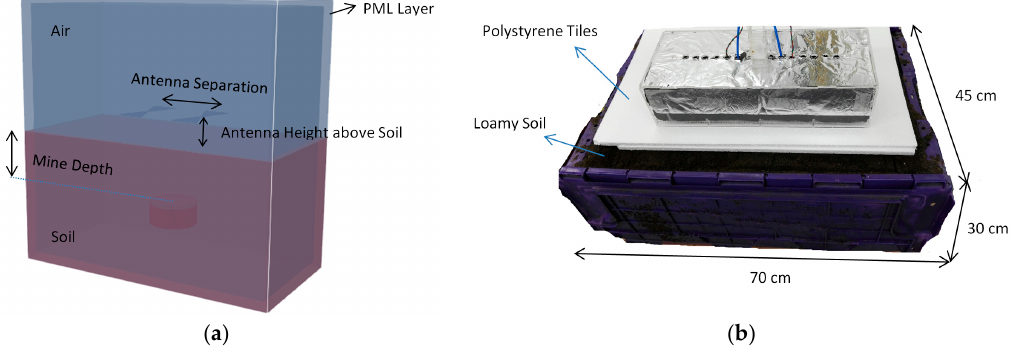
Figure 5. Side-by-side antennas above soil: ( a ) Simulation setup; ( b ) Measurement